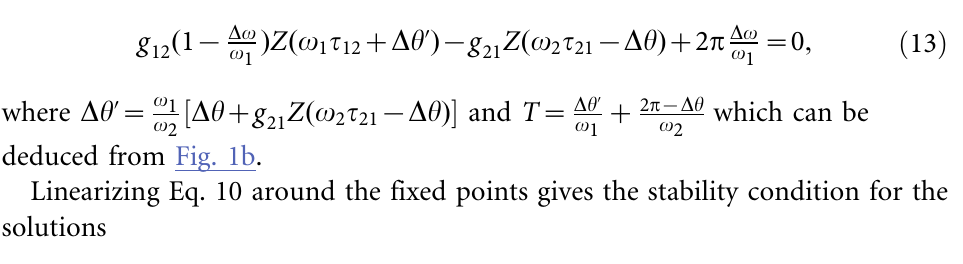
PLOS ONE | DOI:10.1371/journal.pone.0112688 December 8,